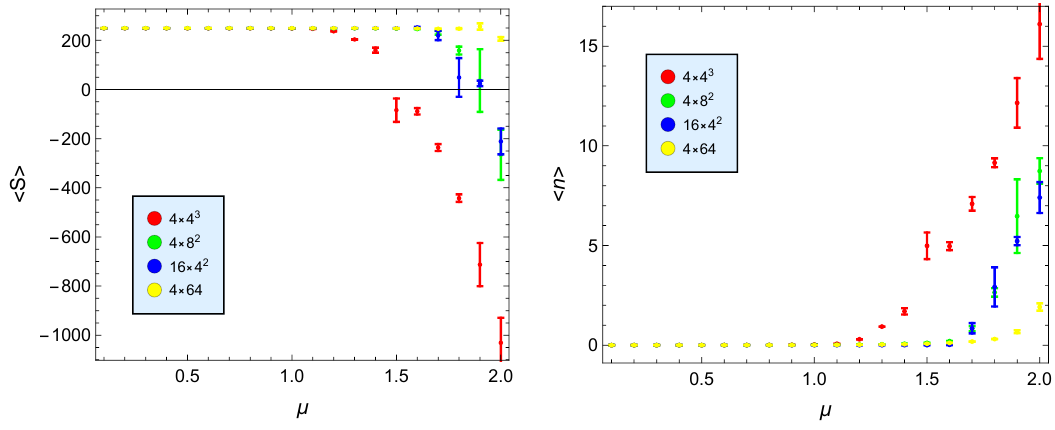
Figure 12 . The expectation values of the action (left) and the density (right) as a function of (the mass parameter increases from µ for lattices with 256 sites at various dimensions for α = 1 √ 9 5 ’ 2 . 236 for d = 2 ) evaluated using the simple first order contour. The m = 1 for d = 4 to m = lattices are identified as L × ˜ L d − 1 . We observe the Silver Blaze effect starting at different values of µ for different dimensions. The two lattices at d = 3 behave similarly; there seems to be no strong dependence on the geometry in this case. As µ is increased error bars become larger, in light of the reduction of the mean phase factor, which results in a stronger sign problem.